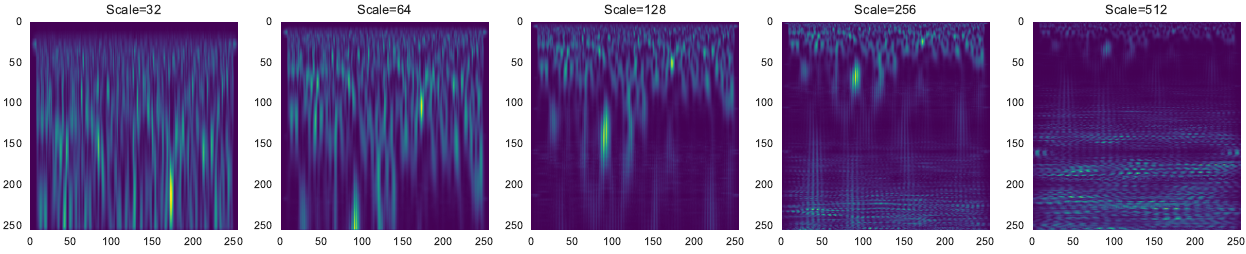
Figure 3. CWT scalogram in different